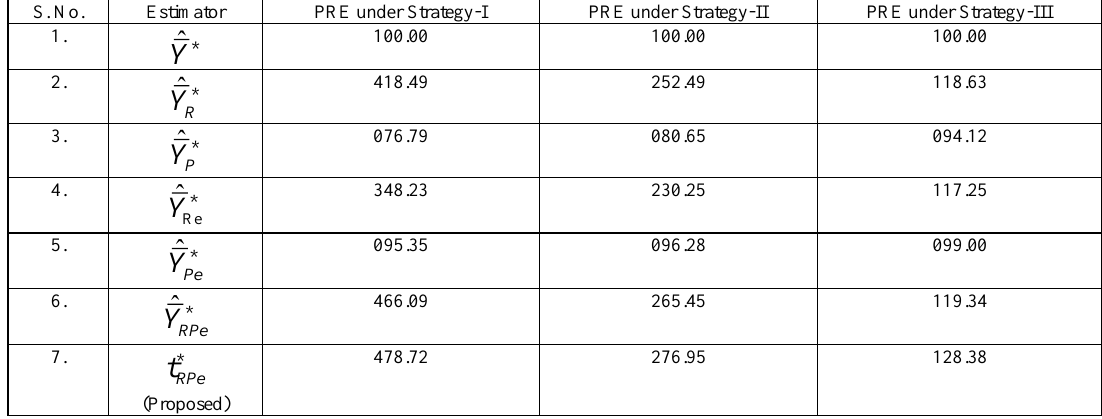
Table 9. PRE of various estimators with respect to the mean per unit estimator for the Population-II S. No. Estimator